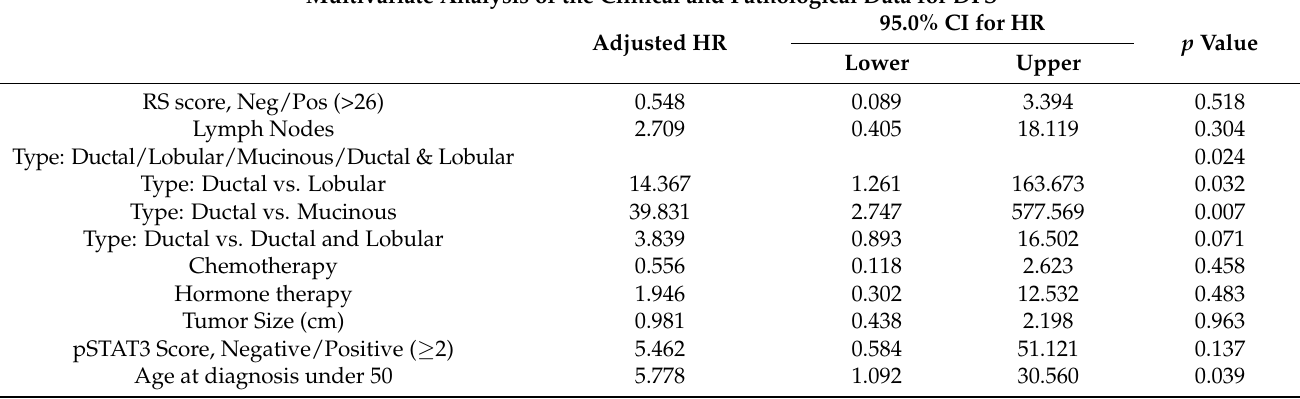
Figure 3. Kaplan – Meier analysis for DFS ( a ) according to the pSTAT3; ( b ) according to the pSTAT3 and adjusted by age at diagnosis.